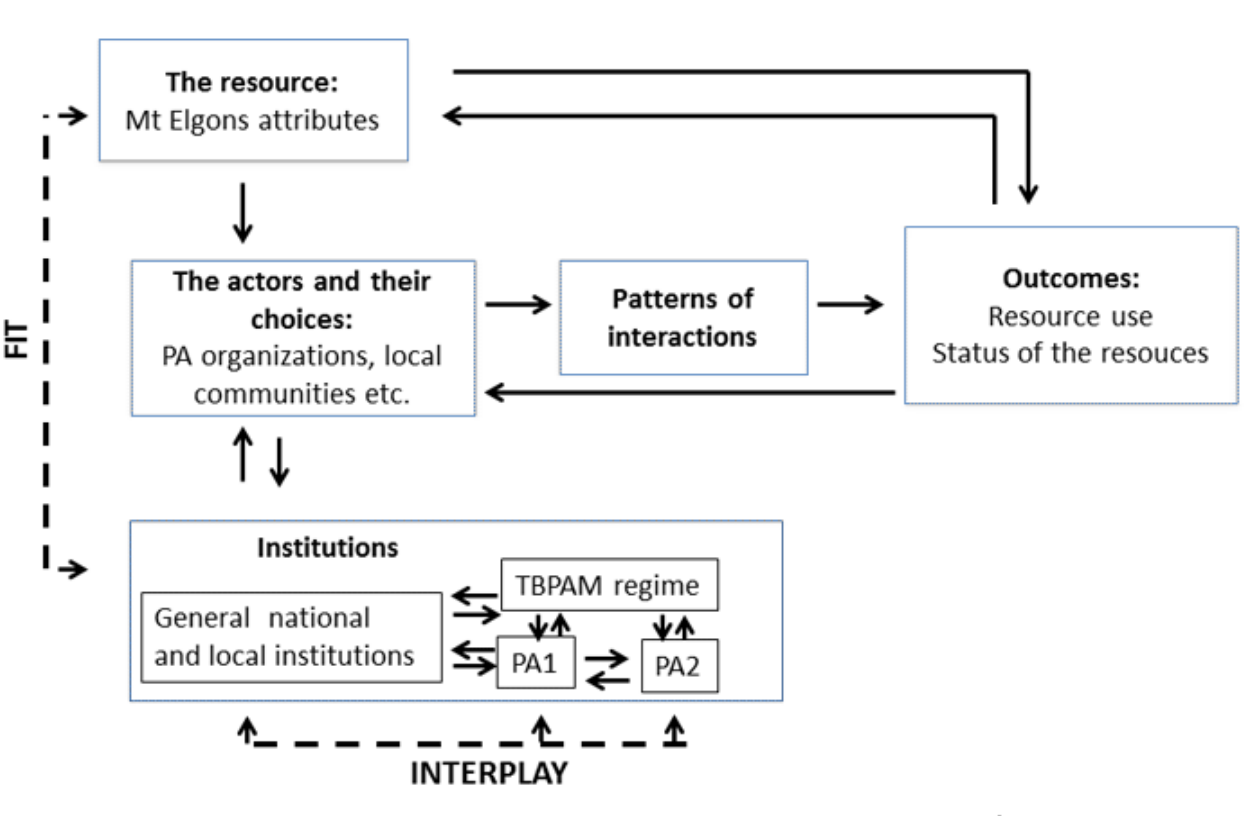
Fig. 1 . Framework for analyzing resource regimes and their impacts. PA = protected